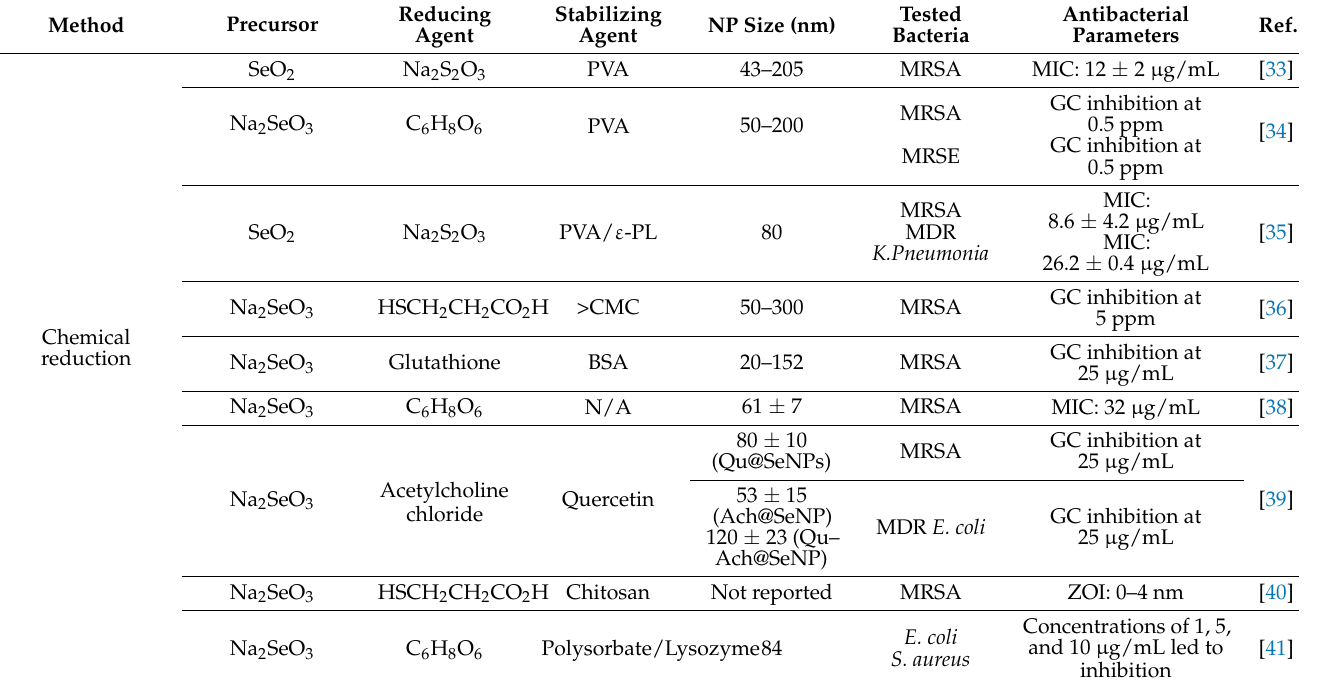
Table 1. Recent advances in the physiochemical synthesis of SeNPs toward antimicrobial applications. Method